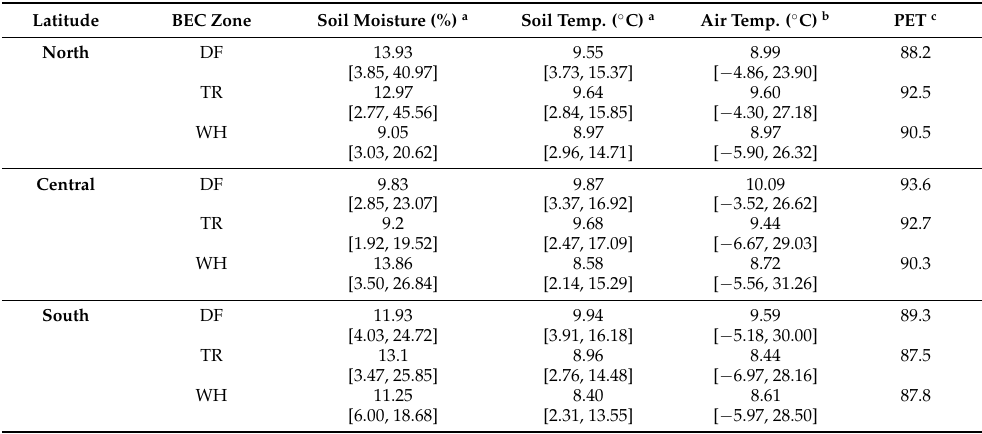
Table 2. In situ climatic conditions measured at nine sites spanning three latitudes (north, central, south) and two biogeoclimatic (BGC) zones (coastal western hemlock (WH), coastal Douglas-fir (DF) or transition between the two (TR)) over 48 months (1 May 2011 to 30 April 2015). Latitude BEC Zone Soil Moisture (%) a Soil Temp. ( ◦ C) a Air Temp. ( ◦ C) b PET c North